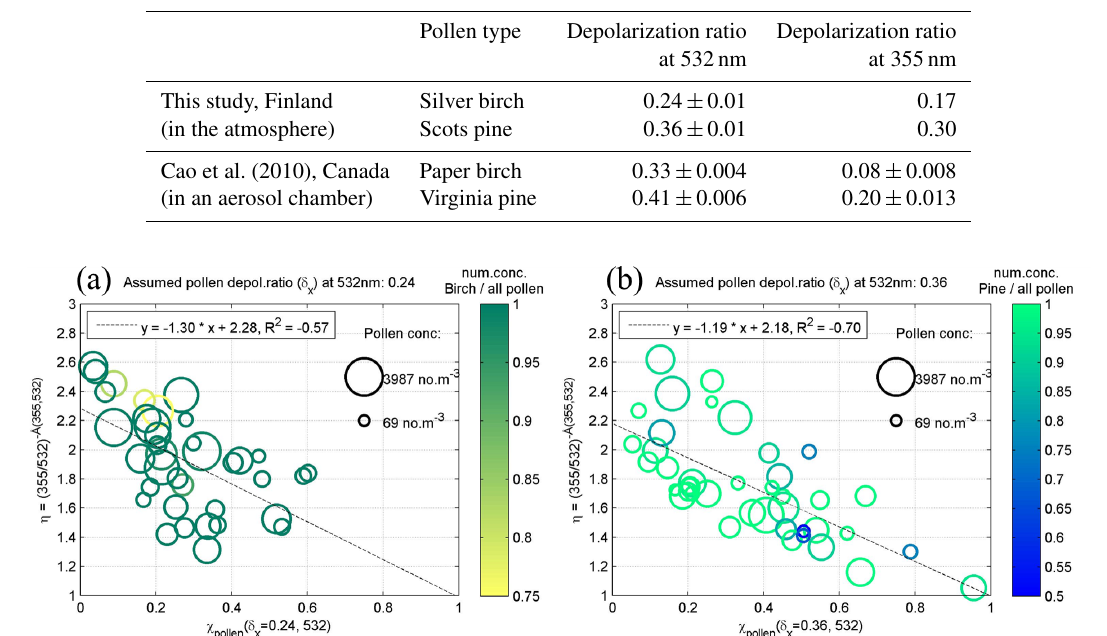
Figure 12. Mean values of the parameter η against pollen backscatter contribution at 532nm ( χ pollen (δ x , 532 ) ) inside the pollen layers, during IPP-1 (a) and IPP-3 (b) . η is a parameter using the backscatter-related Ångström exponent between 355 and 532nm (Eq. 6). The pollen depolarization ratio δ x at 532nm is assumed to be 0.24 for (a) or 0.36 for (b) . Linear regression lines are drawn by dotted lines, with fitting equation shown (Eqs. 5 or 8). The correlation coefficient ( R 2 ) is also given. The size denotes the total pollen concentrations measured by the Burkard sampler at roof level; the colour represents the number concentration of the dominant pollen ( a : birch, b : pine) against the total pollen number concentration. Similar figures using different assumed values of pollen depolarization ratio can be found in the Supplement (Figs. S5 and